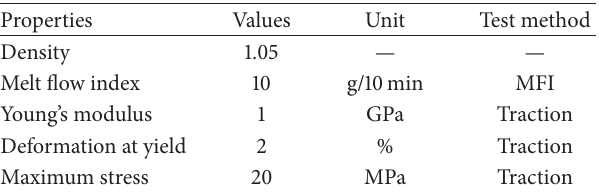
Table 1: ABS characteristics.